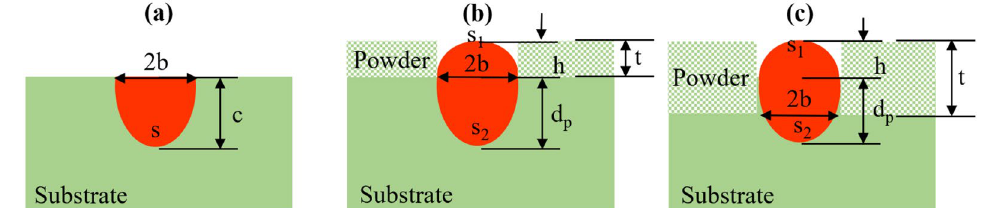
Figure 6 Schematics of single-pass cladding cross-sections: a The bare substrate without powder; b The first powder layer; c The k th powder layer ( k >